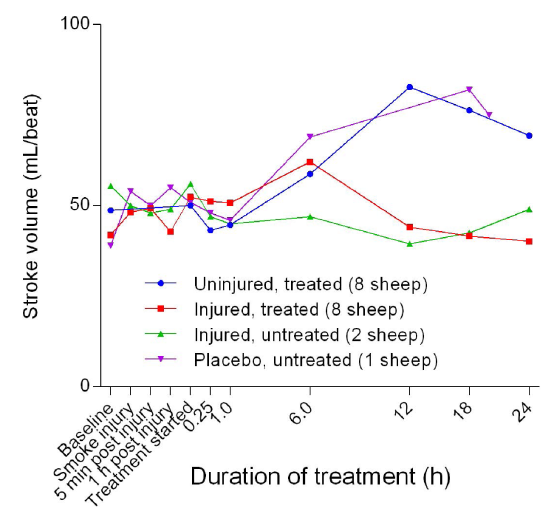
Figure 25. Mean central venous pressure (CVP) (Mean ± SD, error bars not shown) in smoke and non-smoke injured sheep that received extracorporeal life support as compared to that in untreated controls.